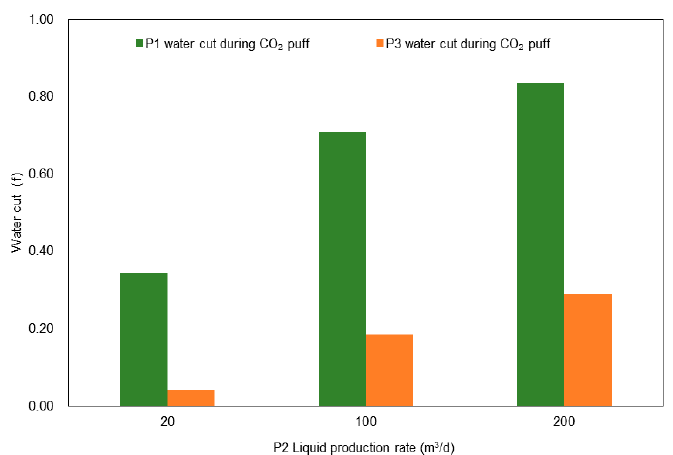
Figure 31. Water cut after opening of the middle well at different liquid production rates.